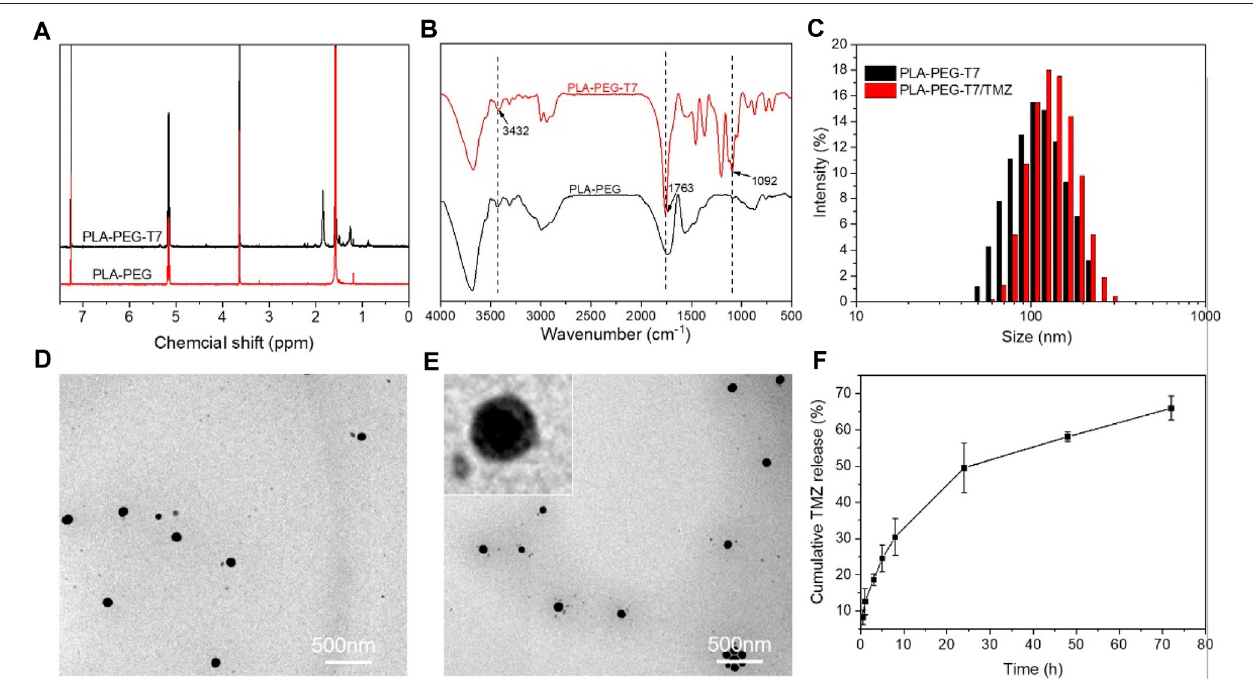
FIGURE 1 | Characterizations of PLA-PEG-T7. (A) 1 H NMR spectra of PLA-PEG and PLA-PEG-T7. (B) FTIR spectra of PLA-PEG and PLA-PEG-T7. (C) Size distributionofPLA-PEG-T7andPLA-PEG-T7/MZ. (D) TEMimageofPLA-PEG-T7. (E) TEMimageofPLA-PEG-T7/TMZ. (F) CumulativeTMZrelease(%)fromPLA-PEG- T7/TMZ in PBS buffer (pH (cid:2) 6.5) values at different time